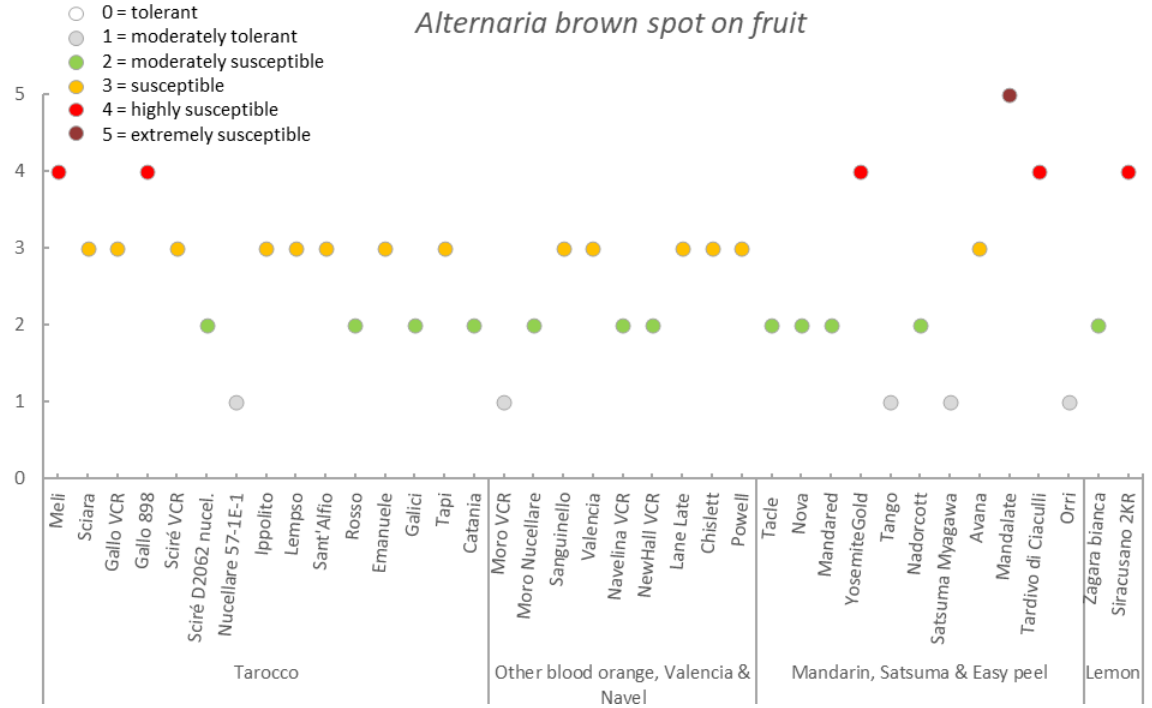
Figure 8. Maximum potential infection risk of Alternaria brown spot on fruit recorded on detected Citrus germplasm. Data obtained from several Sicilian citrus production areas (from 1-to-20) within Citrus groups surveyed for three periods intercepting an eleven-year survey.